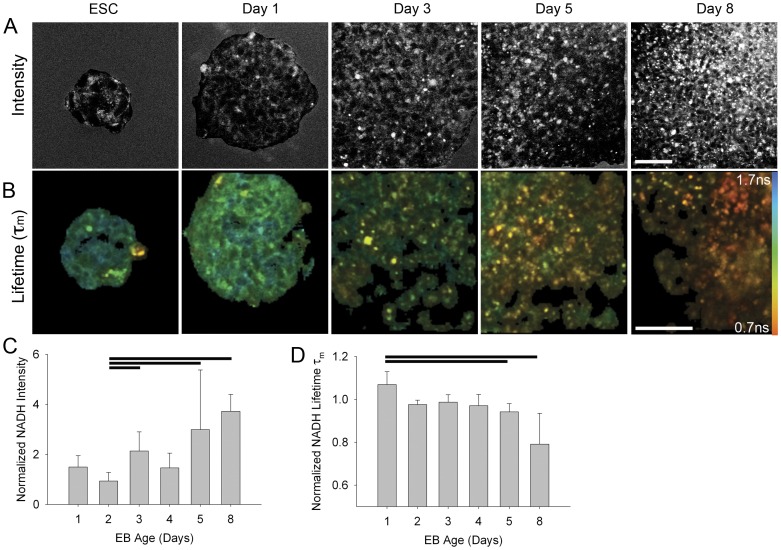
Changes in global endogenous fluorescence intensity fluorescence lifetime with differentiation of mESCs.A, B. MPLSM single optical sections of mouse ESCs at different stages of differentiation (ESC and days 1, 3, 5, and 8 of EB formation; ESC: n = 24, 27, 14, 23, 13, 4 colonies, respectively; EB: n = 7, 16, 6, 18, 8, 4 EBs, respectively) using 780 nm excitation. A. Endogenous fluorescence intensity images following application of a background subtraction FIJI plugin macro (see Methods) to remove 90% of the background of the region of interest prior to intensity analysis. Complete timeline of images, including raw image data, is in Figure S1. B. Color mapped lifetime values of MPLSM single optical sections of mouse ESCs at different stages of differentiation (mESC and days 1, 3, 5, and 8 of EB formation; ESC: n = 13, 20, 8, 18, 10, 18 colonies, respectively; EB: n = 7, 7, 6, 12, 7, 3 EBs respectively) using 780 nm excitation. Color bar indicates lifetime values for τm. Detailed statistics in text and Figure S2. Scale bars = 50µm. C. Background subtracted fluorescence levels were normalized by the mean background subtracted intensity per pixel of the mESCs for that day. For this, and all subsequent figures, bars are mean ± standard deviation. Horizontal lines indicate statistical difference (P<0.05) between normalized EB intensity values (Dunn’s method pairwise multiple comparison following ANOVA). D. Quantitation of lifetime values for τm of NADH (780 nm excitation). Values are normalized to corresponding mean mESC lifetime values. Horizontal lines indicate statistical difference (P<0.05) between normalized mEB lifetime values (Dunn’s method pairwise multiple comparison following ANOVA).